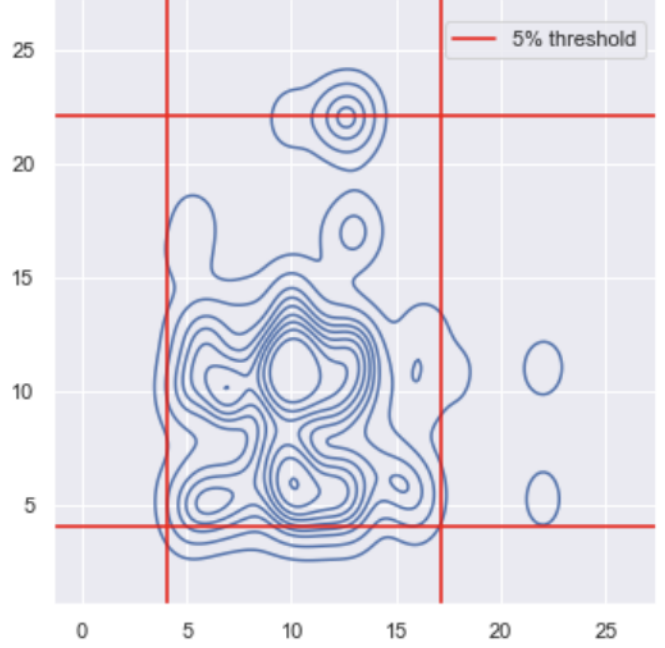
Figure 14. Distribution of the testing bivariate Fourier values of both the respiration and the ocular movement and the thresholds (red lines) as defined as Figure